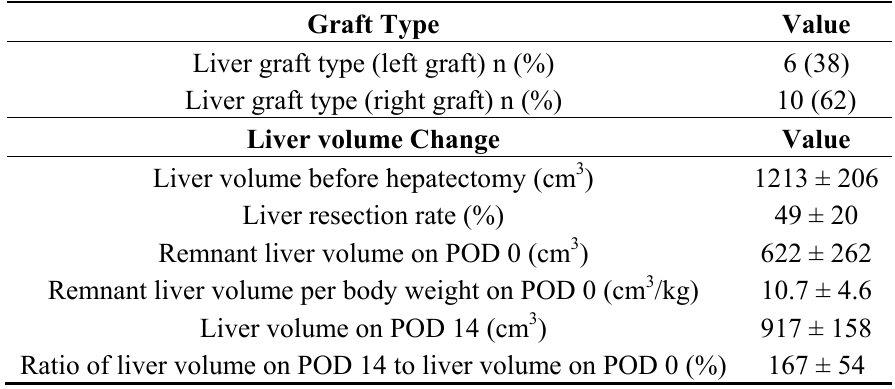
Table 2. Liver graft type and changes of liver volume before and after